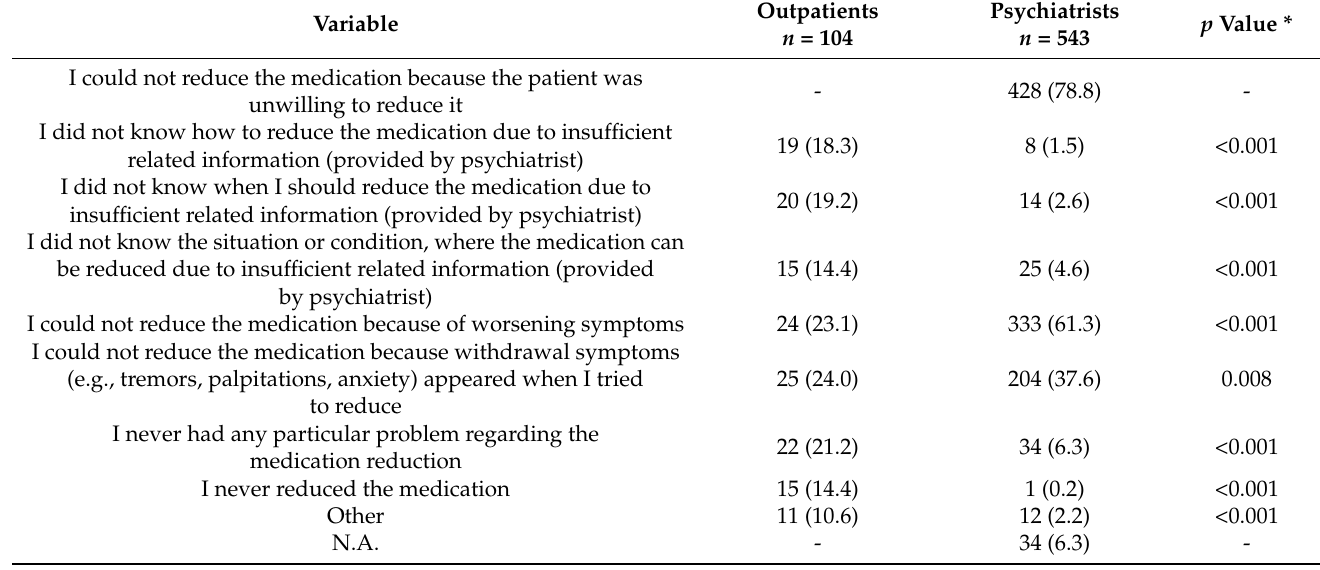
Table 5. Difficulties cited while attempting to reduce hypnotic/anxiolytic in the past (multiple